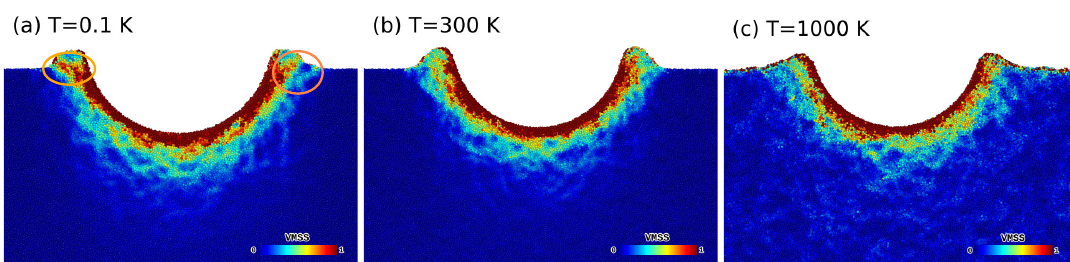
Figure 3. Cross-sectional view of the von–Mises shear strain (VMSS) at maximum indentation depth (70 Å) for temperatures of ( a ) T = 0.1 K, ( b ) T = 300 K and ( c ) T = 1000 K. The orange circles in ( a ) highlight wing-like shear